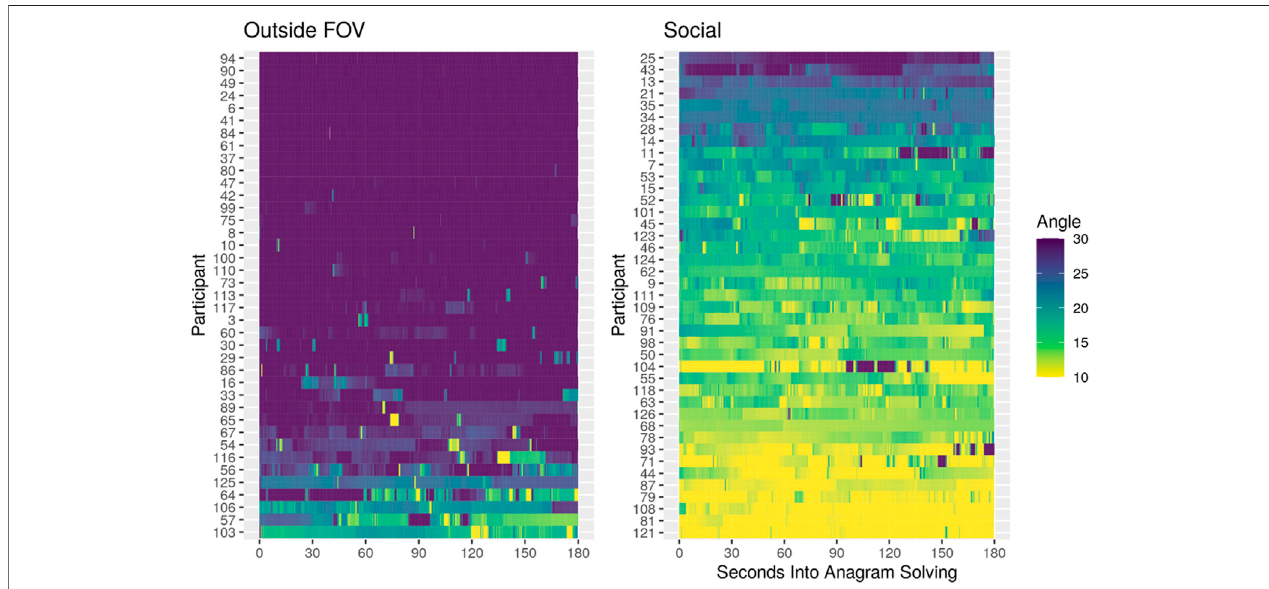
FIGURE 6 | Angle between head-forward and direction of virtual human for each participant in the study over time.